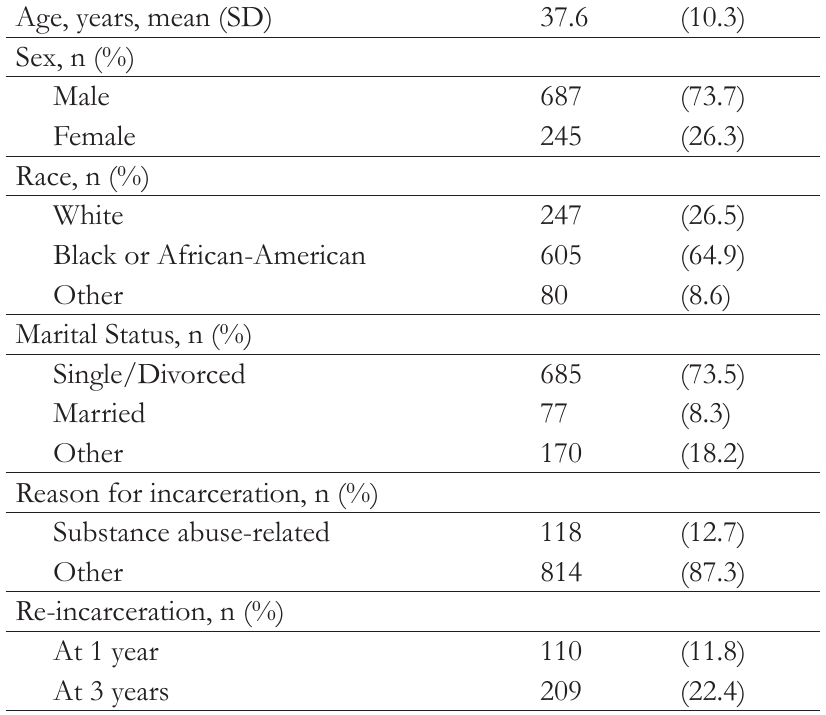
Table 1. Baseline Subject Characteristics